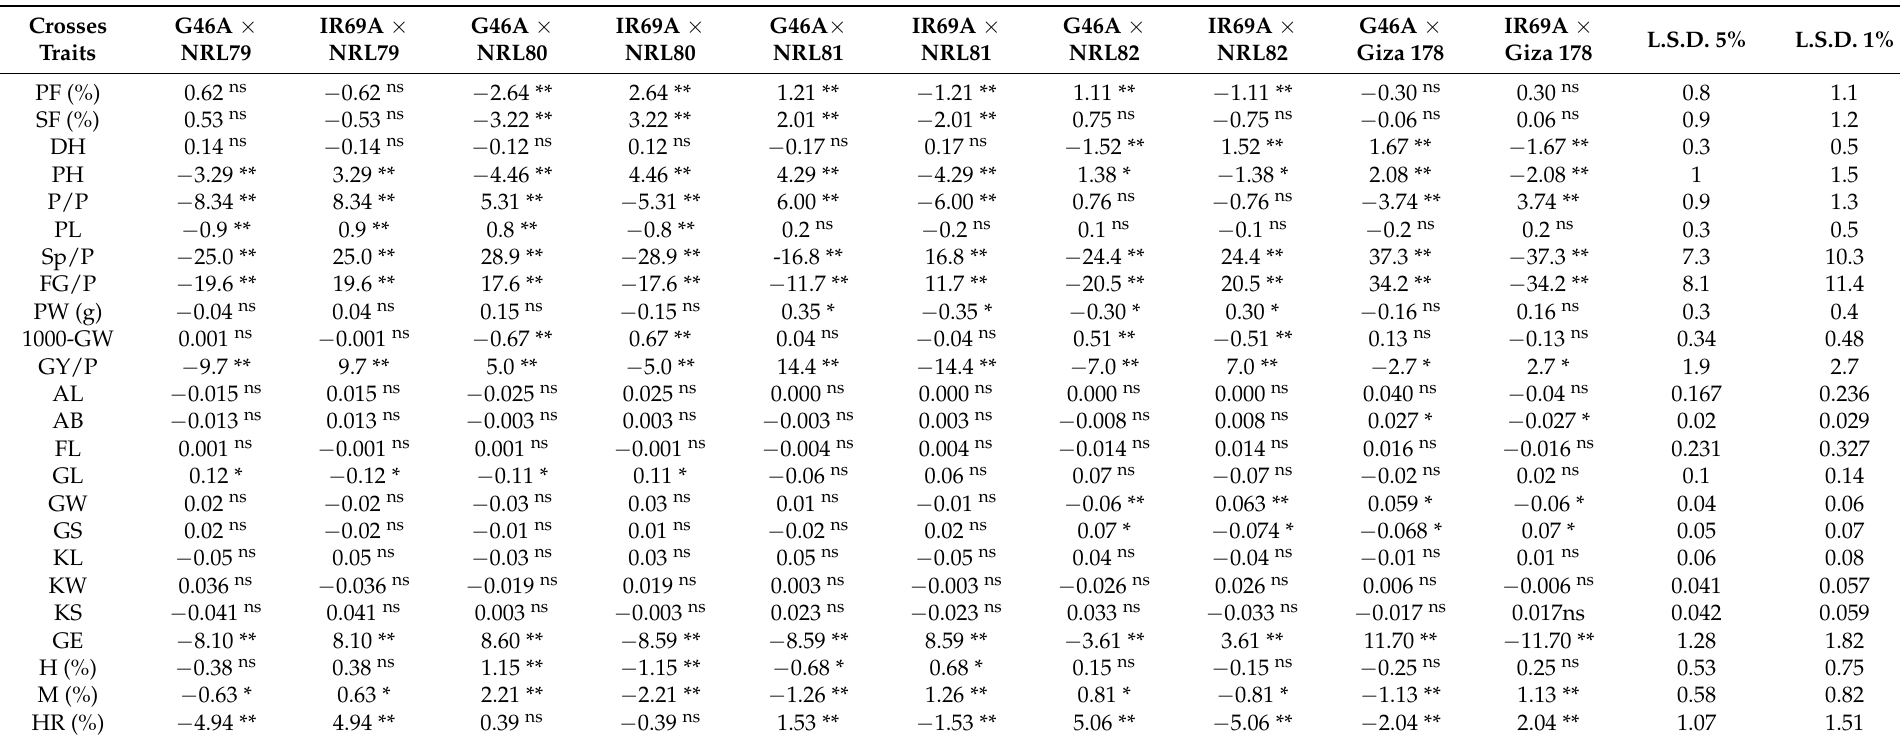
Table 6. Specific combining ability for the grain yield, yield contributing traits, floral traits, and grain quality traits of the